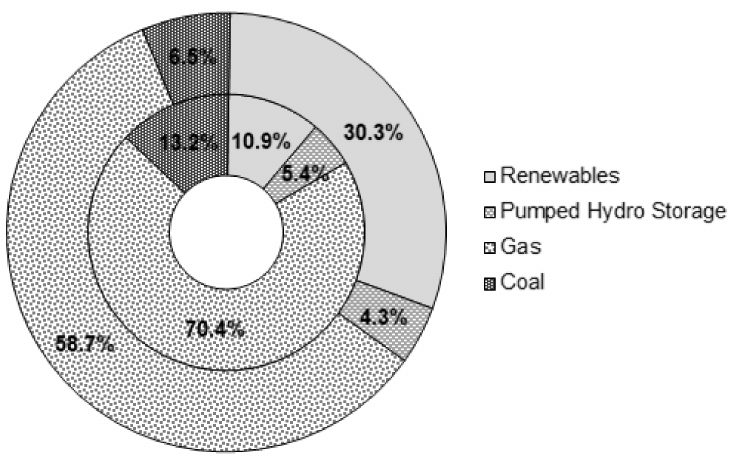
Figure 5. Increase (internal circle) and decrease (external circle) in generation by fuel on the BM during the PAR50 period. Data sourced from Elexon